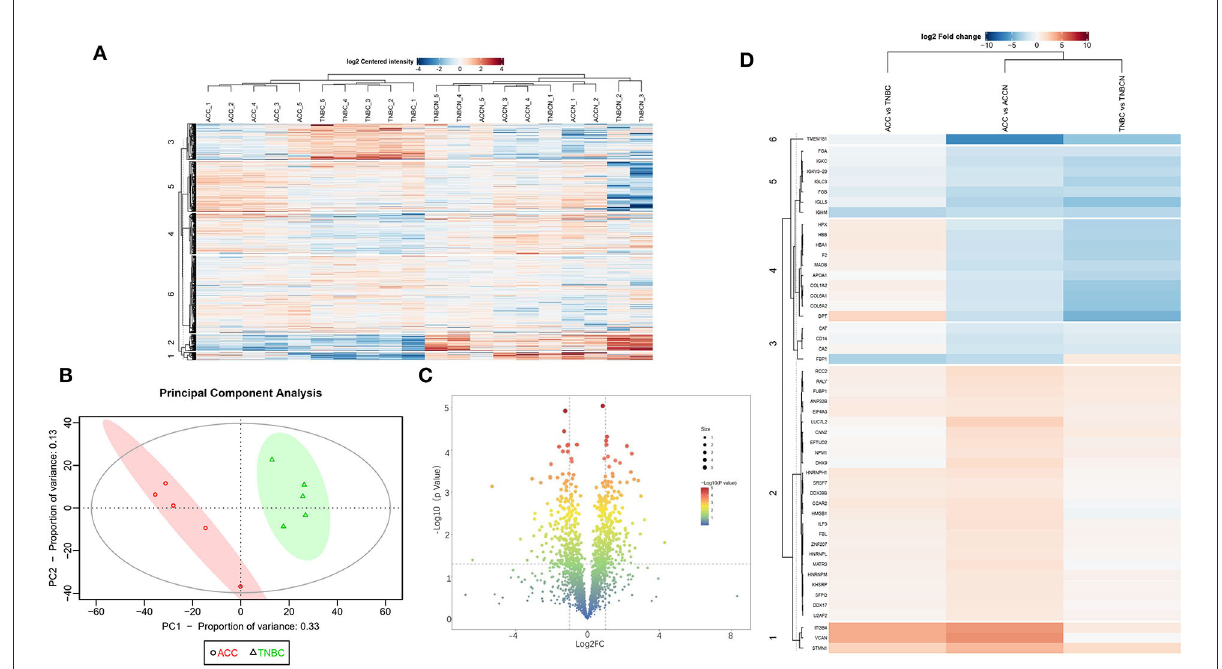
FIGURE2 (A) Heat map of all DEPs among ACC, BL-TNBC, and the adjacent normal breast tissue. (B) PCA of the proteomic data from ACC (red) and BL-TNBC (green). (C) Volcano plots of the proteomic analysis showing the variance in expression between ACC and BL-TNBC. The dotted vertical lines indicate one standard deviation from the mean fold change. (D) Heat map of top 50 DEPs between ACC and BL-TNBC, ACC, and adjacent normal breast tissue, as well as BL-TNBC and adjacent normal breast tissue. The detailed DEPs are listed on the left line.